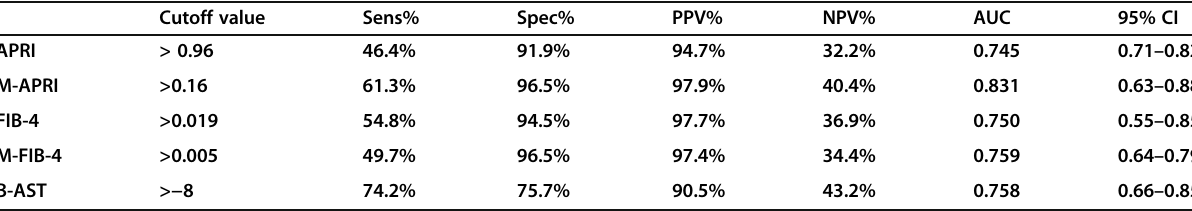
Table 5 Performance of the studied non-invasive markers in the detection of early (F1 – F2) in the studied group Cutoff value